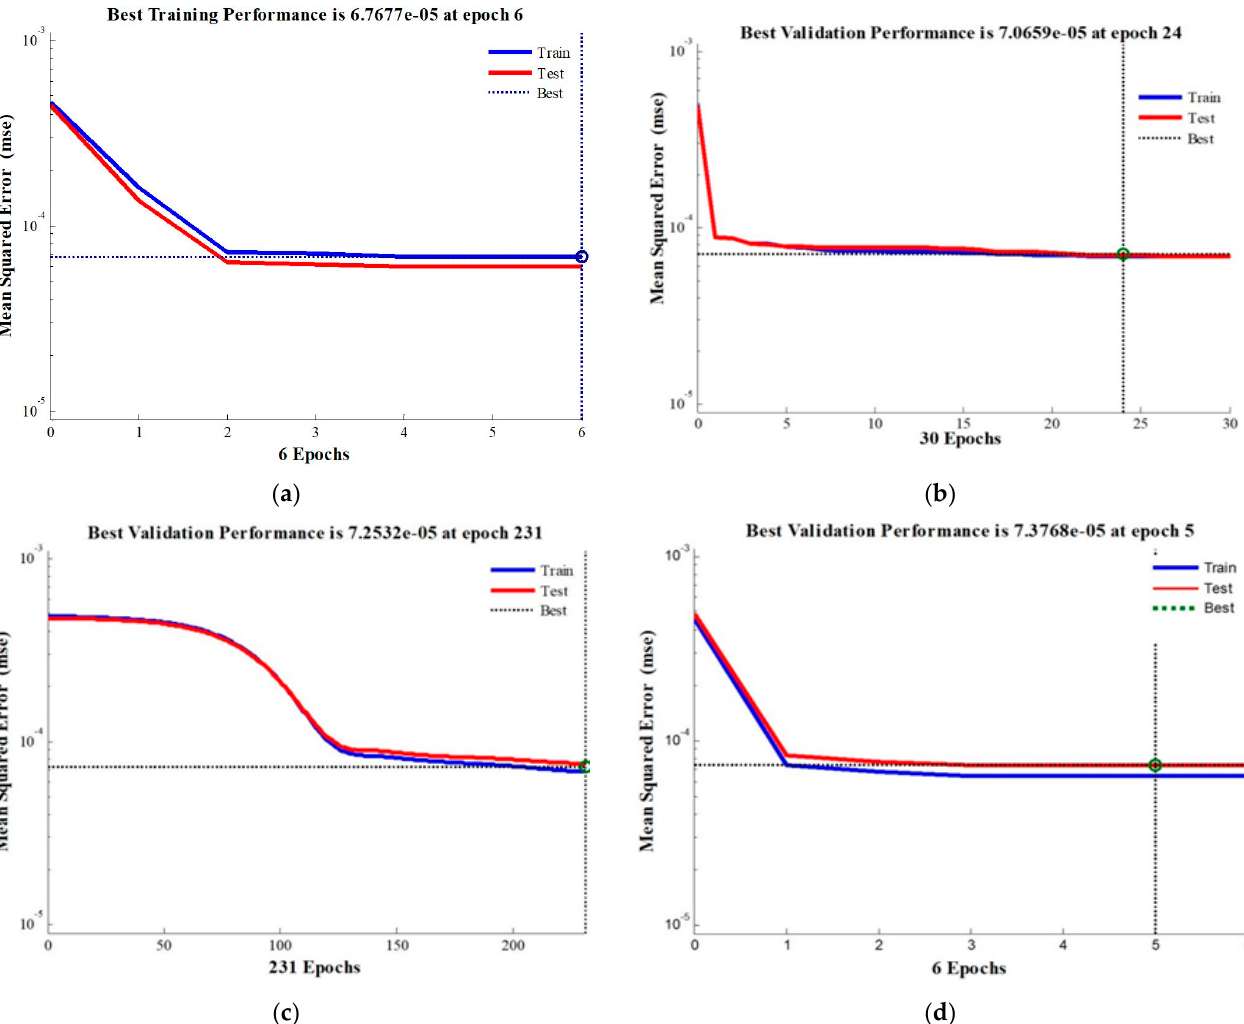
Figure 7. Mean square error diagram for cascaded forward backdrop using ( a ) Bayesian Regulation, ( b ) Polak-Ribiere Restarts, ( c ) Gradient Descent with momentum and adaptive learning rate, and ( d ) Levenberg-Marquardt Algorithm.